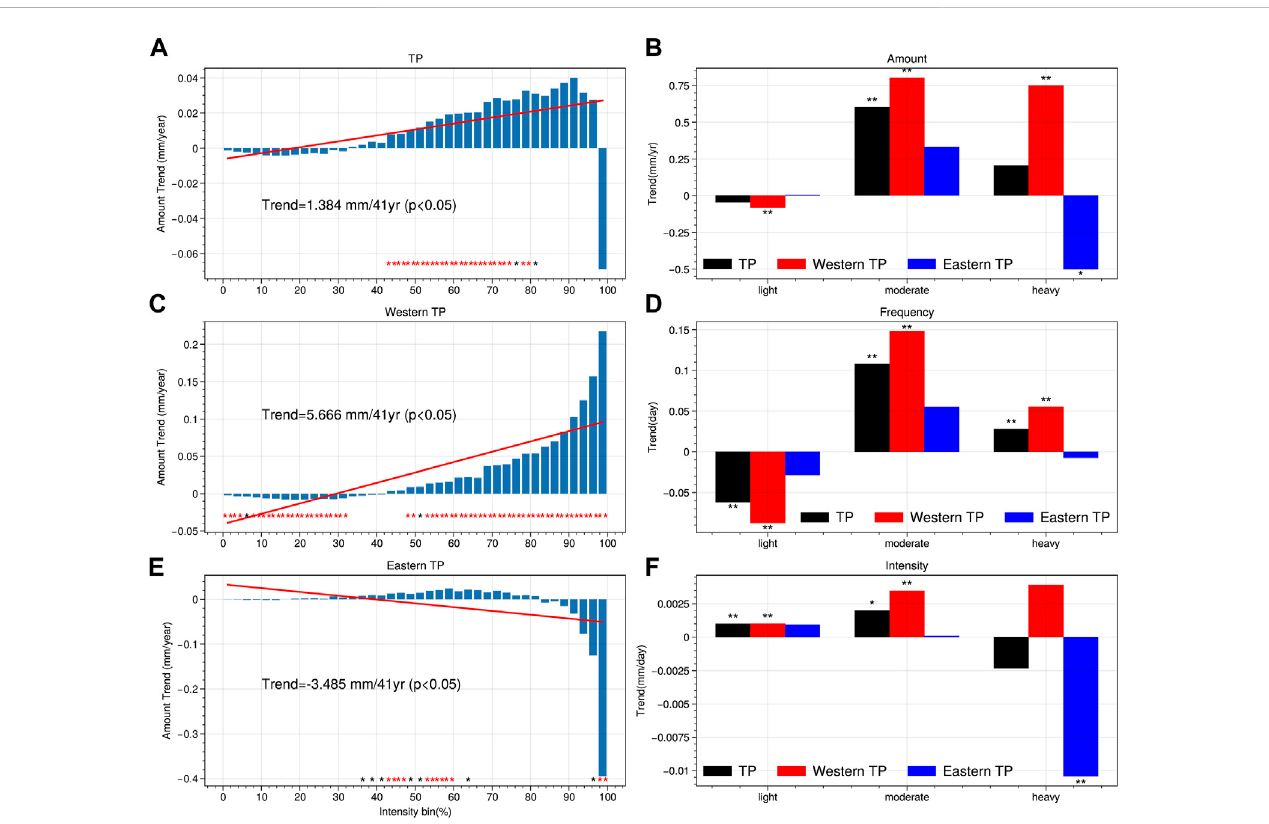
summer of 1979 – 2019. In (A,C,E) , linear trend (blue bars) of precipitation amount in the summer as a function of 40 precipitation percentile intensity bins during 1979 – 2019 averaged over the TP (A) , western TP (C) , and eastern TP (E) . The red lines indicate the shift rates of precipitation intensity. In (B,D,F) , linear trends of the amount (B) , frequency (D) and intensity (F) of light precipitation, moderate precipitation, and heavy precipitation over the TP (black bars), westernTP(redbars)andeasternTP(bluebars).Thedoublestarsandredstarsindicatestatisticalsigni fi canceexceeding95%,andthesinglestarandblackstar indicate statistical signi fi cance exceeding